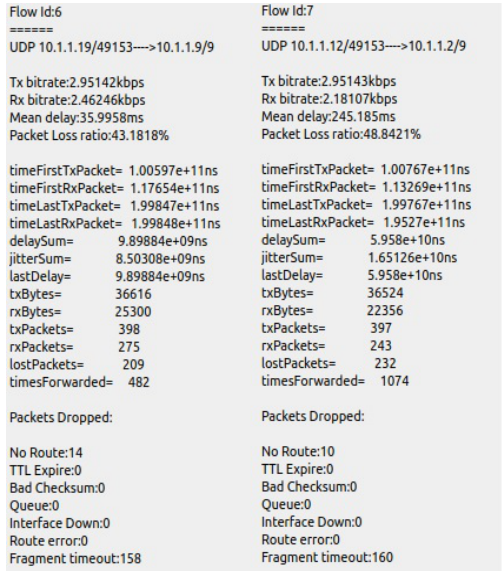
Figure 4. NetAnim Image of the Flow IDs.